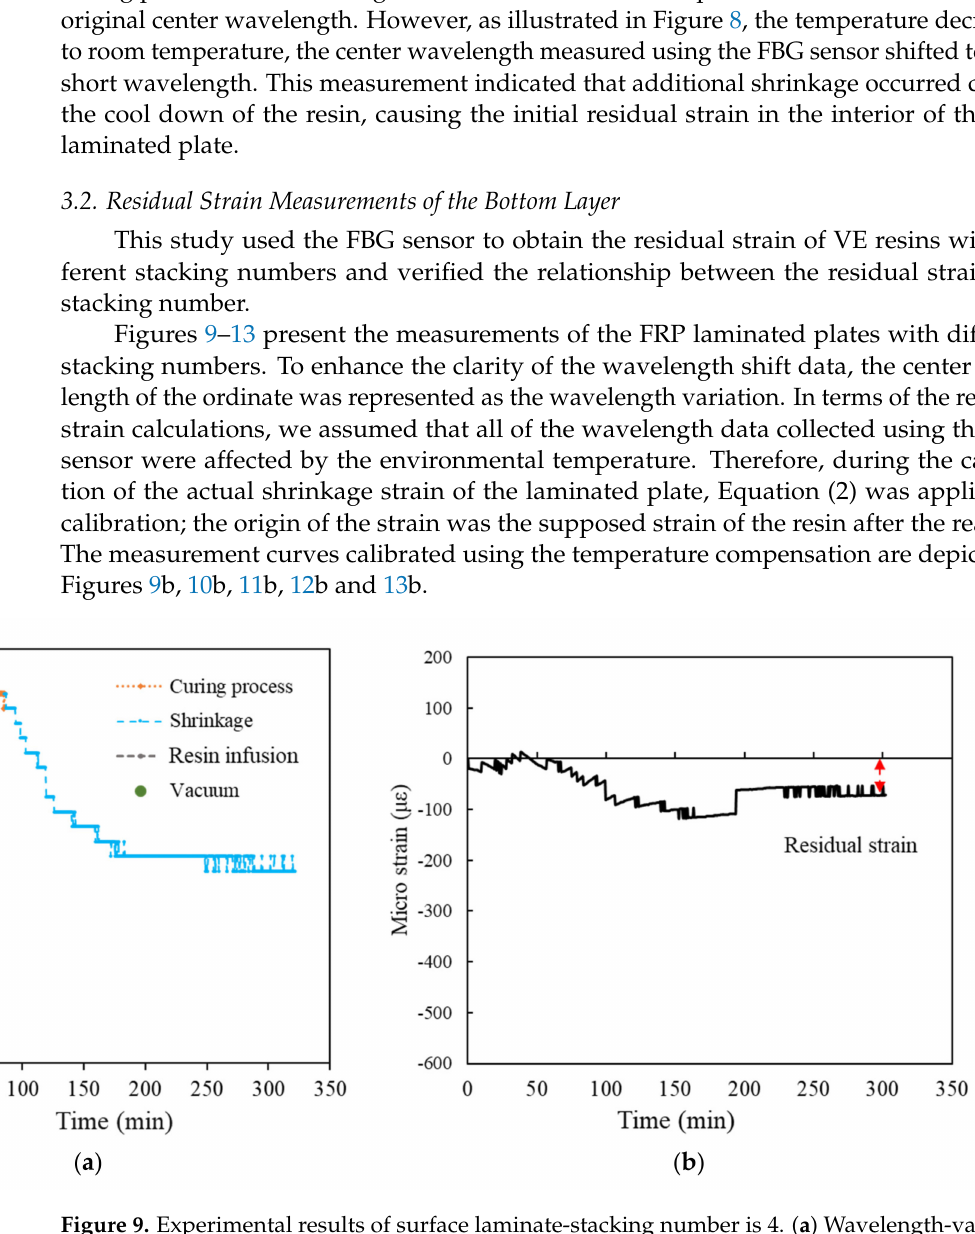
Figure 9. Experimental results of surface laminate-stacking number is 4. ( a ) Wavelength-variation varying with time. ( b ) Residual